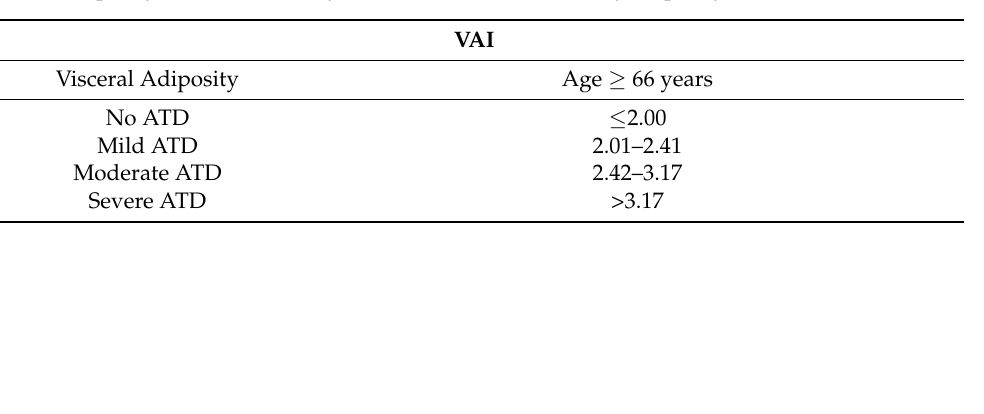
Table 1. Age- and sex-specific cutoffs for assessing visceral adiposity and body adiposity via the visceral adiposity index (VAI), body-mass index (BMI), and body adiposity index